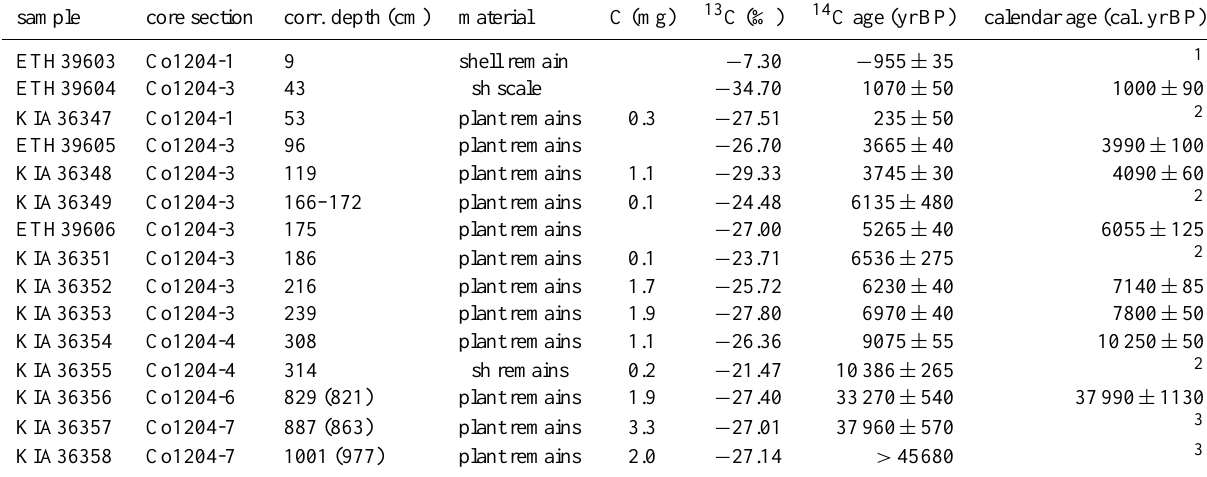
Table 1. Radiocarbon age determinations from Lake Prespa core Co1204. The depth values in brackets of samples KIA36356–KIA36358 indicate depths after subtraction of tephra thicknesses.